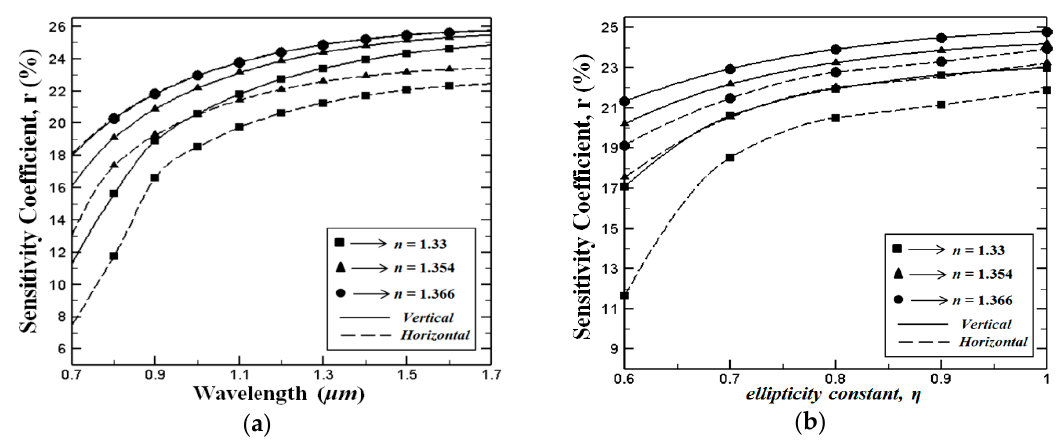
Figure 6 . ( a ) Variation of the sensitivity coefficient r as a function of the wavelength when η = 0.7 and ( b ) variation of the sensitivity coefficient r as a function of the ellipticity constant η , when the wavelength is fixed to 1 µm.